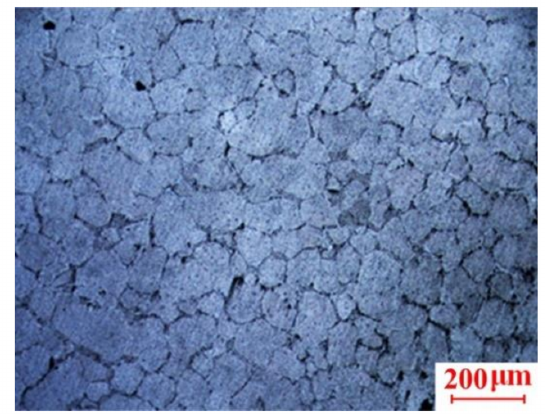
Figure 11. Microstructure of scrolls after the T6 heat